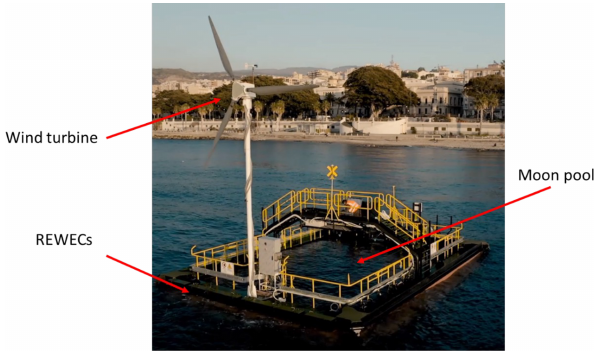
Figure 1. Overview of the model and principal